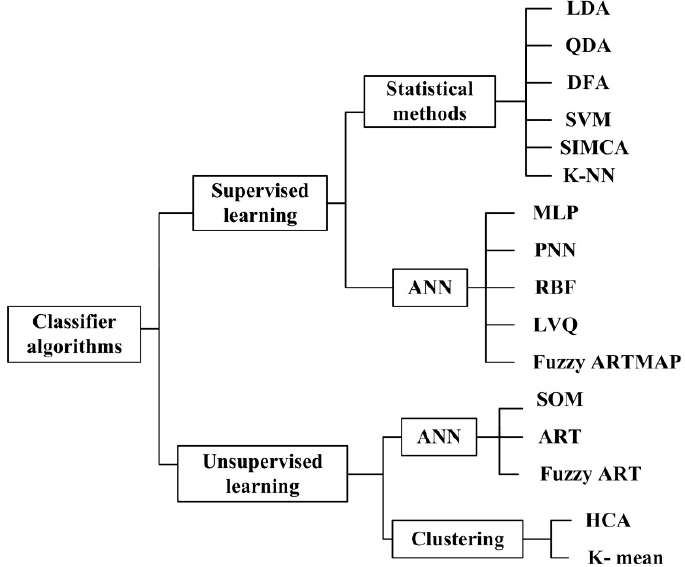
Figure 1. Grouping of classifier algorithms applied to electronic noses (ENs). ANN refers to Artificial Neural Network. ART refers to Adaptive Resonant Theory neural network. ARTMAP refers to Adaptive Resonant Theory Map. DFA refers to Discriminant Factor Analysis. HCA refers to Hierarchical Cluster Analysis. LDA refers to Linear Discriminant Analysis. LVQ refers to Learning Vector Quantization. K-NN refers to K Nearest Neighbors. MLP refers to Multi-Layer Perceptron. PNN refers to Probabilistic Neural Network. QDA refers to Quadratic Discriminant Analysis. RBF refers to Radial Basis Function neural network. SIMCA refers to Soft Independent Modelling of Class Analogies. SOM refers to Self-Organizing Map. SVM refers to Support Vector Machine.